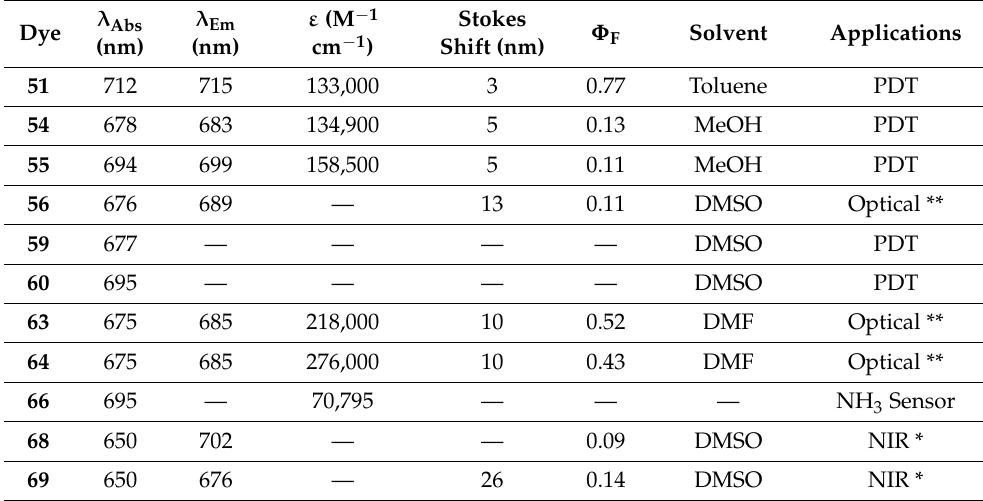
Table 3. Optical properties of selected fluorinated phthalocyanine dyes. λ Abs Dye